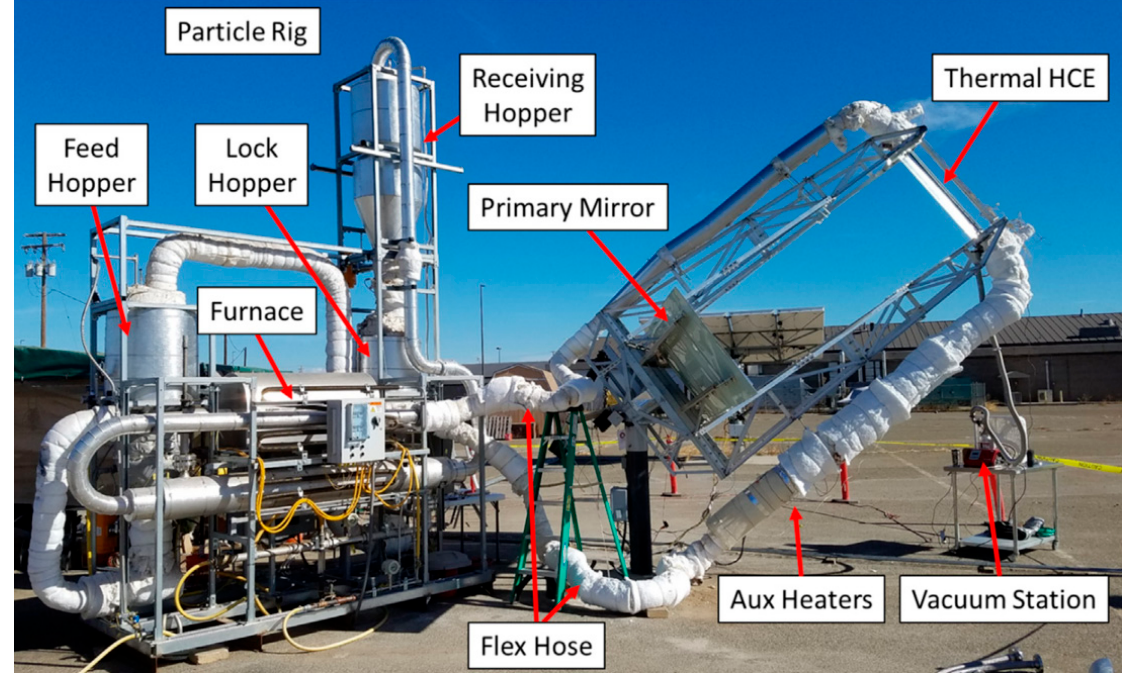
Figure 32. Experimental test platform of two-stage parabolic trough collector [66].